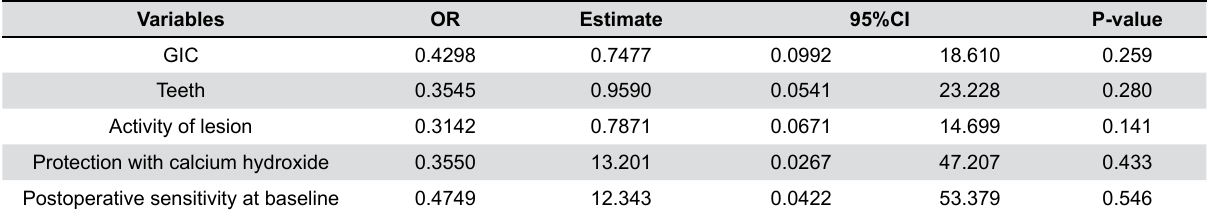
Table 4- Multivariate logistic regression for different variables